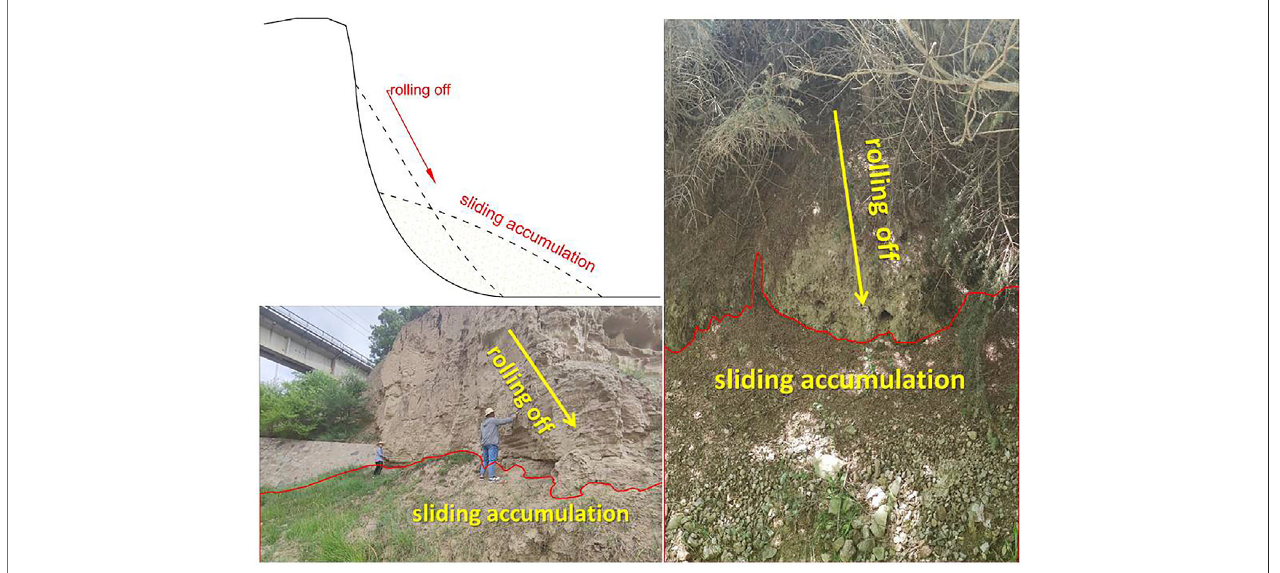
FIGURE 12 | Areas of particle rolling down and slide accumulation in the